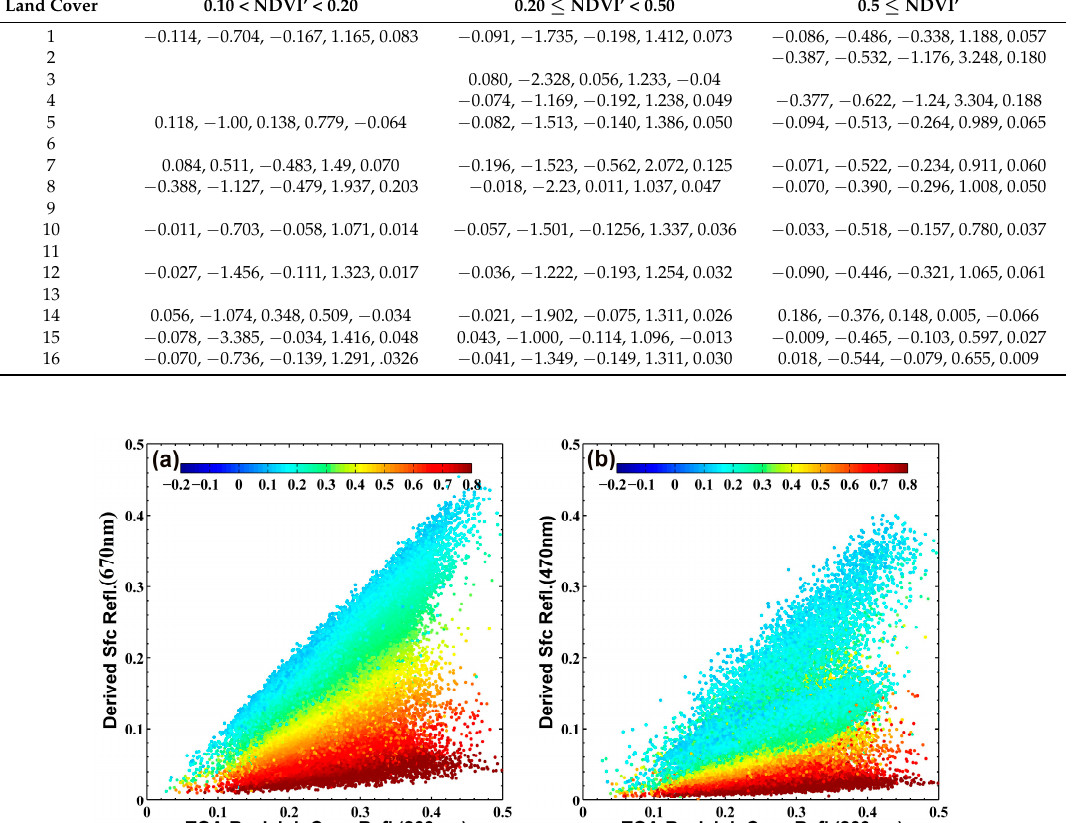
Table 9. Surface Reflectance Coefficients for 0.67 µm for DJF.